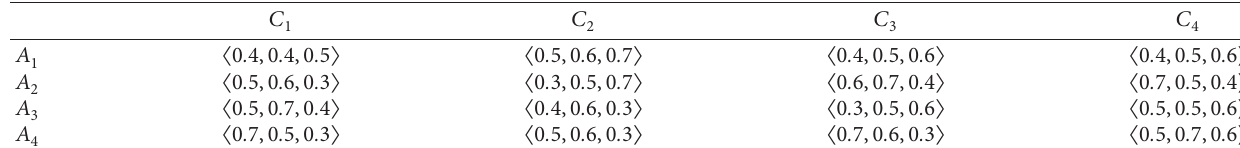
Table 2: Solution matrix for